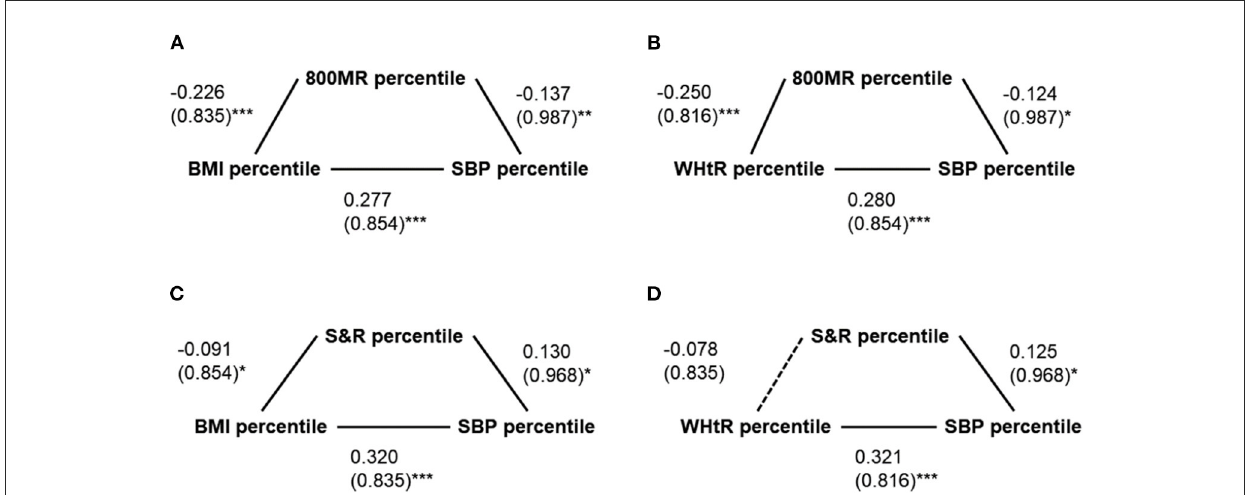
FIGURE1 Simple mediation models of possible mediators of the relationships between anthropometric and blood pressure measures. (A) The 800-m run (800 mR) percentile significantly mediated the relationship between the body mass index (BMI) percentile and the systolic blood pressure (SBP) percentile. (B) The 800 mR percentile significantly mediated the relationship between the waist/height ratio (WHtR) percentile and the SBP percentile. (C) The S&R significantly mediated the relationship between the BMI percentile and the SBP percentile. (D) The S&R percentile did not significantly